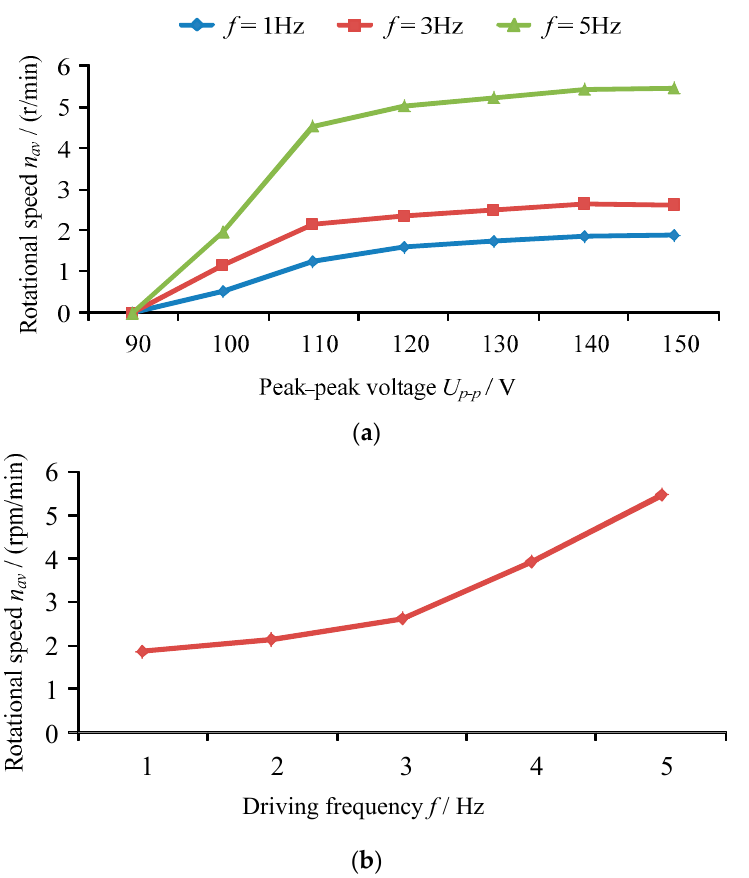
Figure 16. Rotational speed test results of the piezoelectric actuator. ( a ) The change of rotation speed with driving voltage at different frequencies; ( b ) The speed varies with frequency.